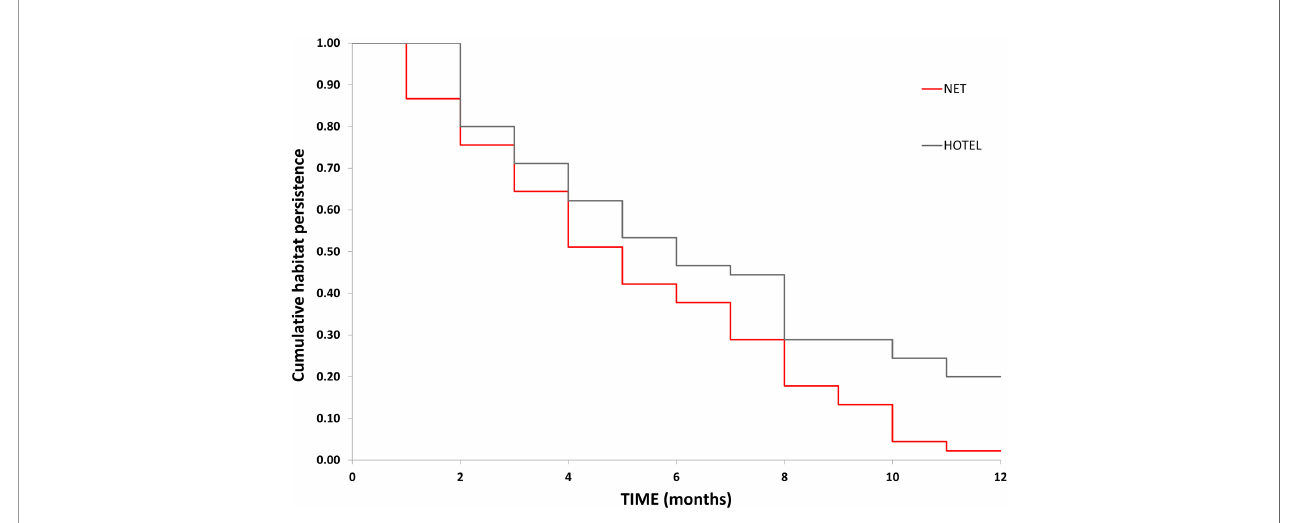
FIGURE 5 | Kaplan-Meier cumulative habitat persistence estimates for captive-bred seahorses released onto the protective swimming net and seahorse